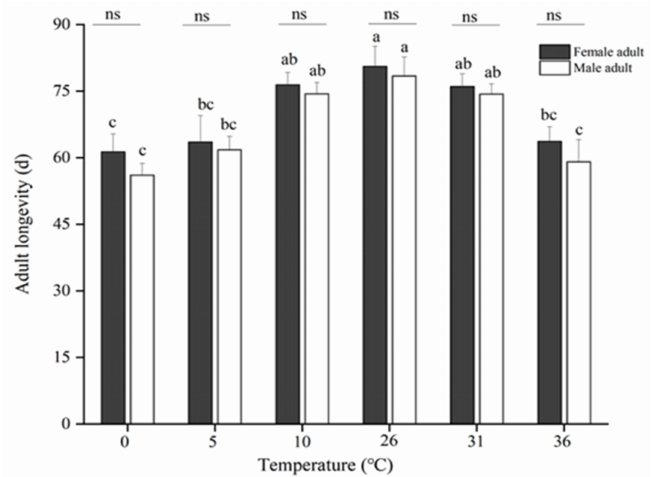
Figure 4. Adult longevity of B. dorsalis after 12 h of high- and low-temperature treatments. Different lowercase letters on the same color bar indicate significant differences ( p < 0.05, Tukey’s test). Data are expressed as means ± standard errors of four replicates. ns ( p > 0.05) indicates the longevities of females and males at same temperature are not significantly